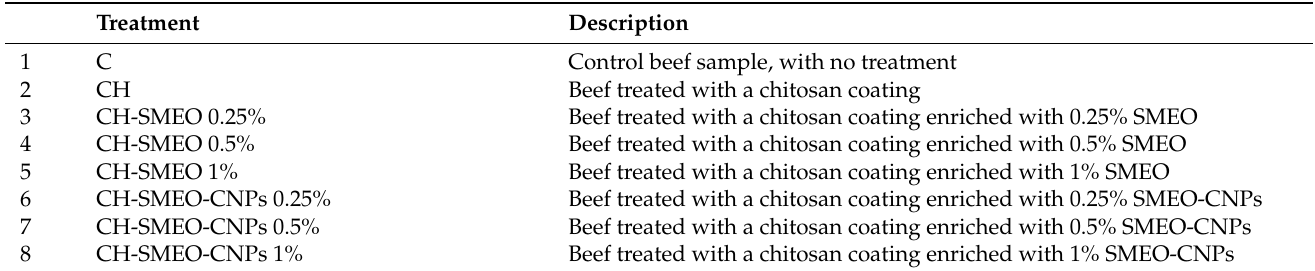
Table 1. Description of different treatments in present